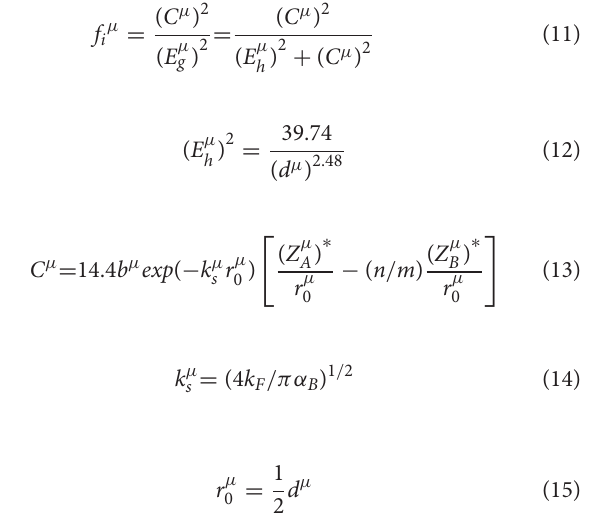
f i (Mo-O), the largest f i value of 85.64% was obtained in Ce- 85.18 to 85.14% with the Sn 4 + doped shifted from 0 to 0.06.